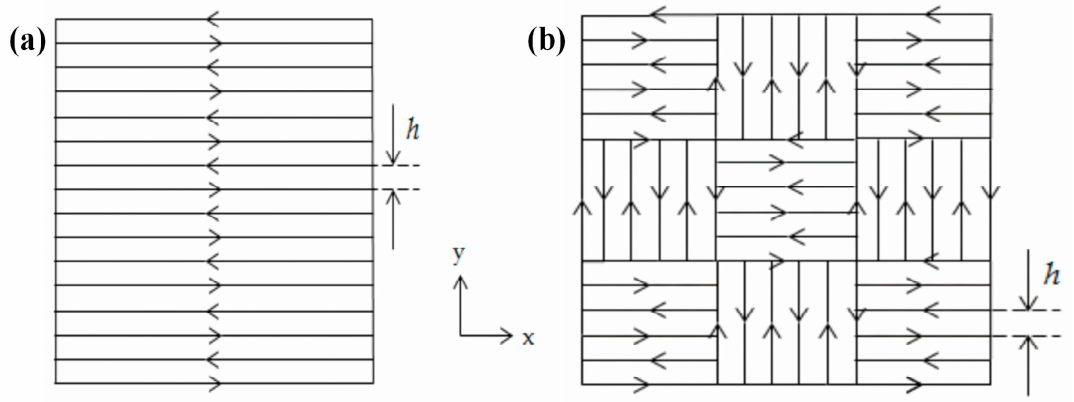
Figure 3. ( a ) Parallel scan line method; and ( b ) chessboard or island scanning strategy.